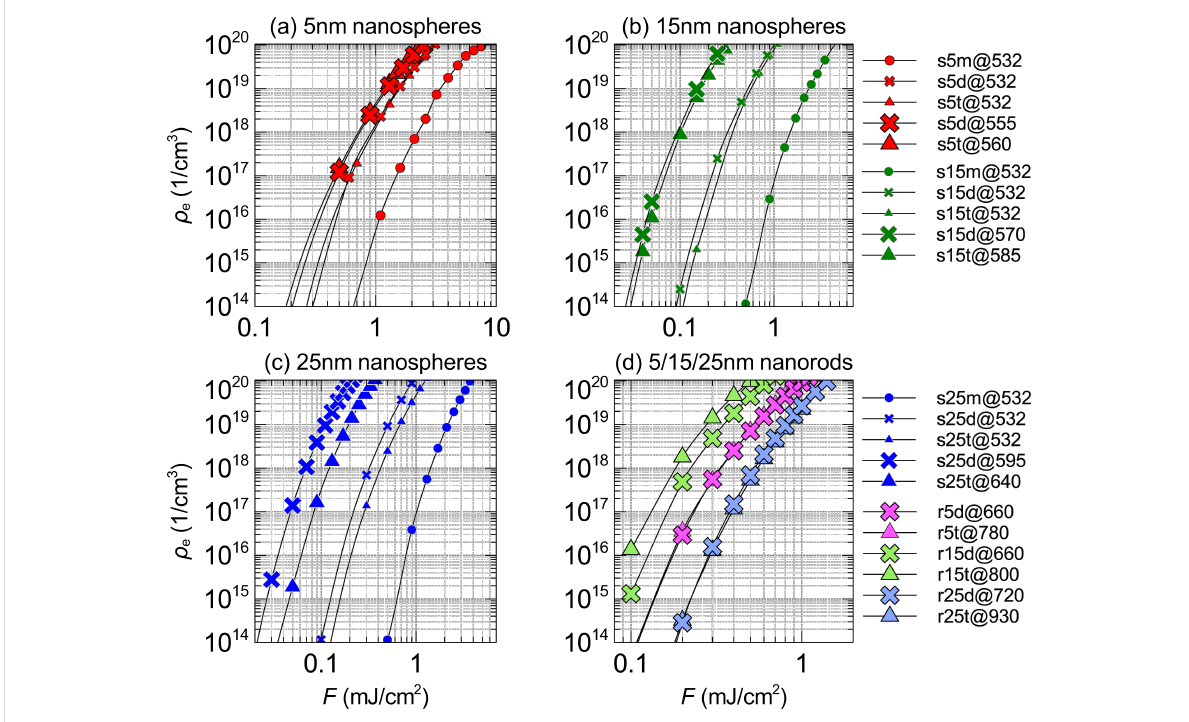
Figure 6: Calculated free-electron densities for different nanoparticle morphologies and wavelengths of 6 ps laser pulses at different fluences, F . The legend provides information about nanoparticle type (“s” means sphere and “r” means rod), incident wavelength (e.g., “@532” corresponds to 532 nm) of the laser pulse and the aspect ratio of the nanosphere assembly or nanorod, (“m”: monomer (circles), “d”: dimer (crosses), “t”: trimer (triangles). The numbers 5 (red), 15 (green), 25 (blue) and 5 (light red), 15 (light green), 25 (light blue) corresponds to the radii of nanospheres and nanorods in nanometers, respectively.